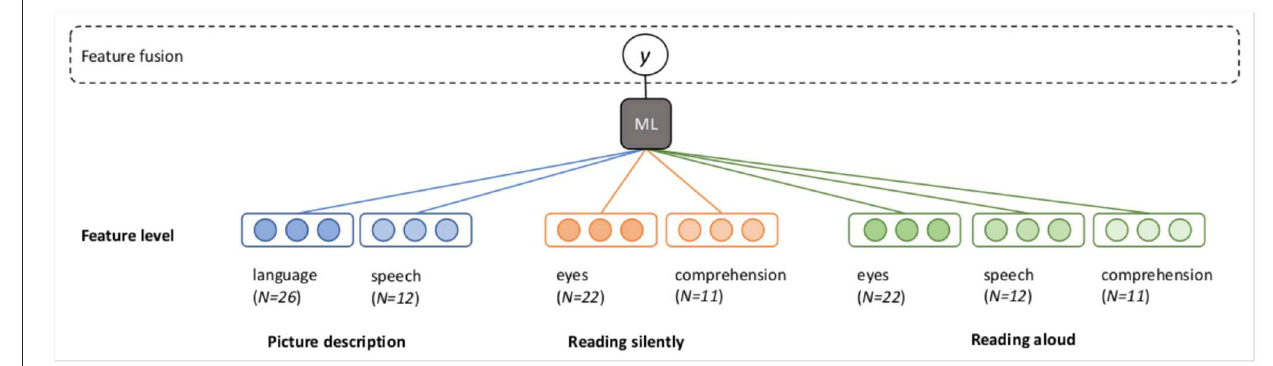
FIGURE 2 | Fusion at the feature level (early fusion).